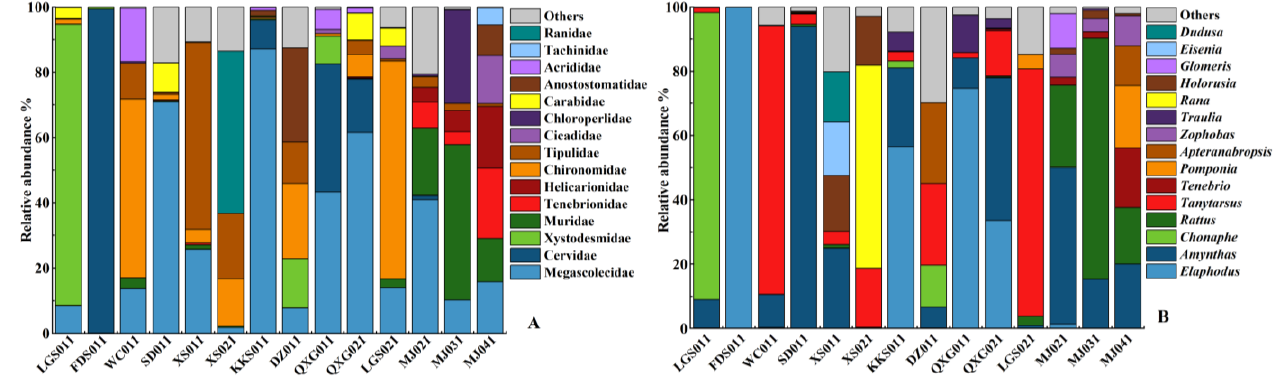
Figure 3. Relative animal food source abundance for wild boars at the ( A ) family level and ( B ) genus level. At the family level (Figure 3A), the invertebrates, such as Megascolecidae (35.15%), Xystodesmidae (10.23%), Tenebrionidae (3.76%), Helicarionidae (3.39%), and Chironomi- dae (2.68%), were the important winter animal food sources of wild boars. Mammals, such as Cervidae (23.65%) and Muridae (6.45%), are also an important component of the diet of wild boars, while Ranidae (0.72%) can only be detected in six samples, showing little